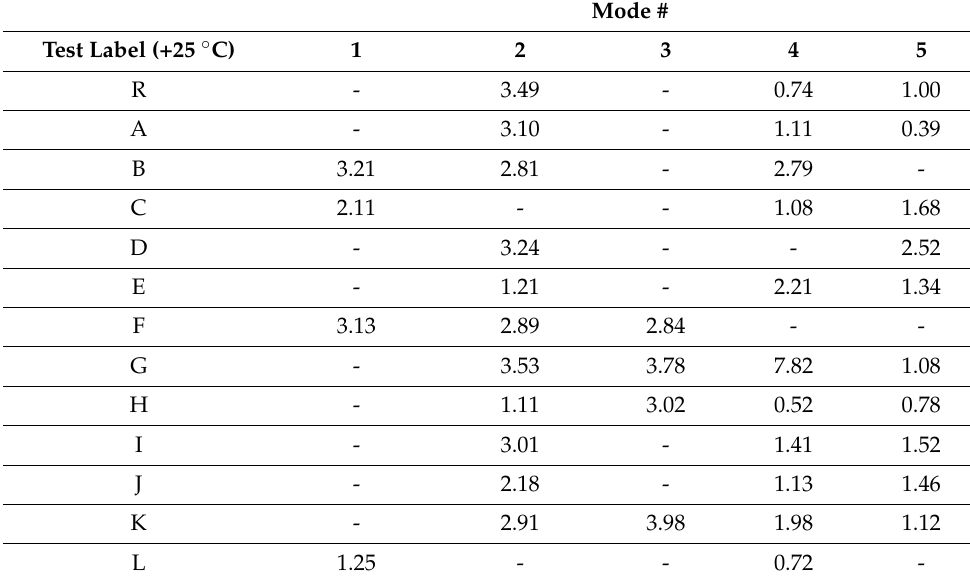
Table 9. Estimated damping ratios of the wind turbine blade corresponding to the identified modal frequencies by the TVF-EMD